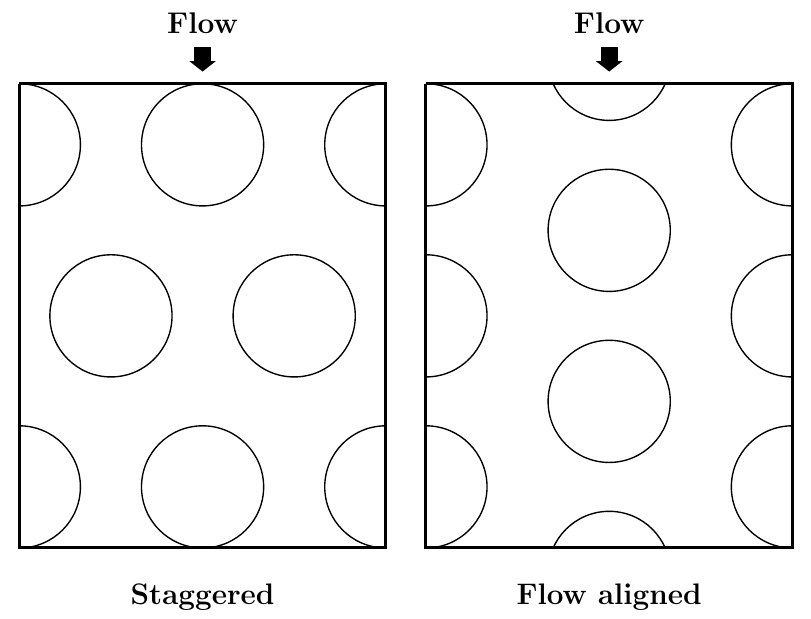
Figure 3. Most popular dimples layout: staggered ( left ) and flow aligned ( right